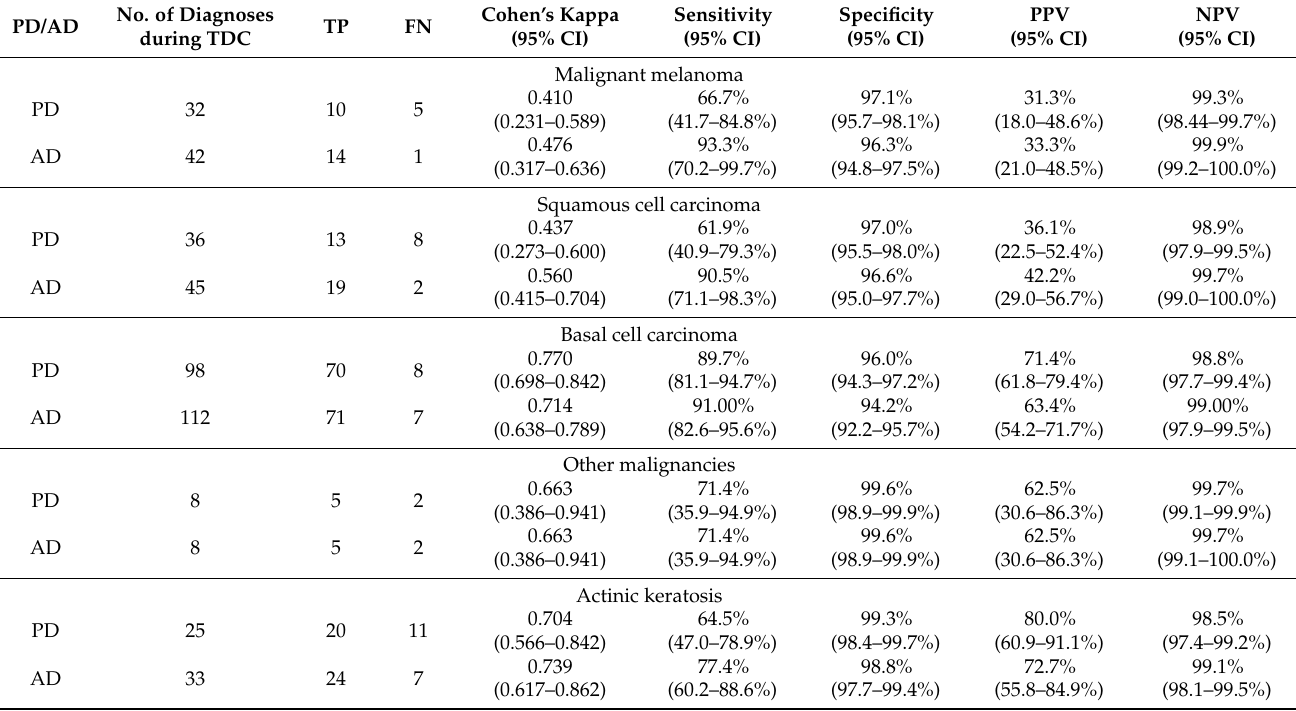
Table 4. Diagnostic parameters and concordance of malignant diagnostic